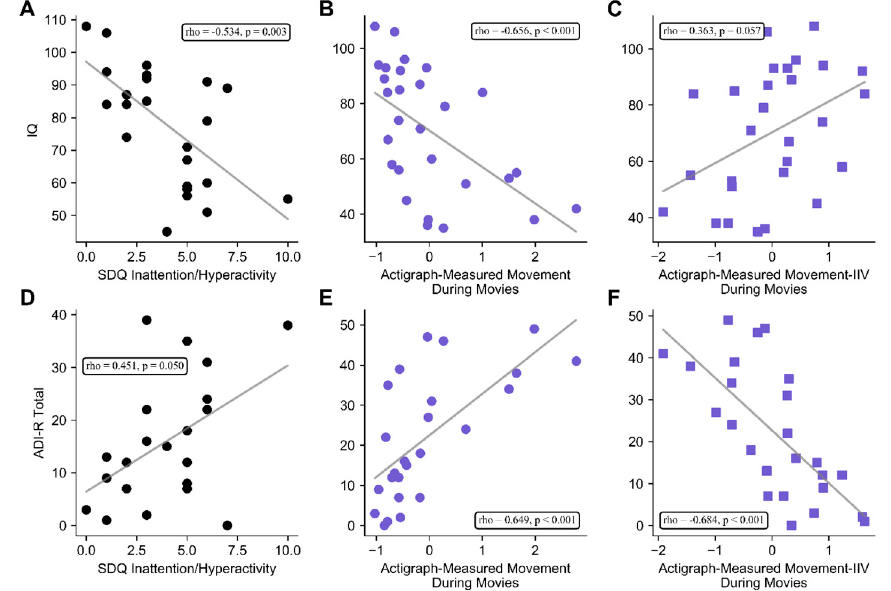
Figure 2. Associations between intellectual ability (IQ), ASD symptoms, and actigraph measurements. IQ was negatively associated with parent-rated ADHD symptoms ( A ) and actigraph-measured movement during movies ( B ); IQ also trended towards being positively associated with actigraph-measured movement IIV during movies ( C ). ASD symptoms were positively associated with ADHD symptoms ( D ) and actigraph-measured movement during movies ( E ). ASD symptoms were also positively correlated with actigraph-measured movement IIV during movies ( F ). Lines represent least-squares fit, insets show rho and p values for Spearman correlations after adjustment for age and testing site.